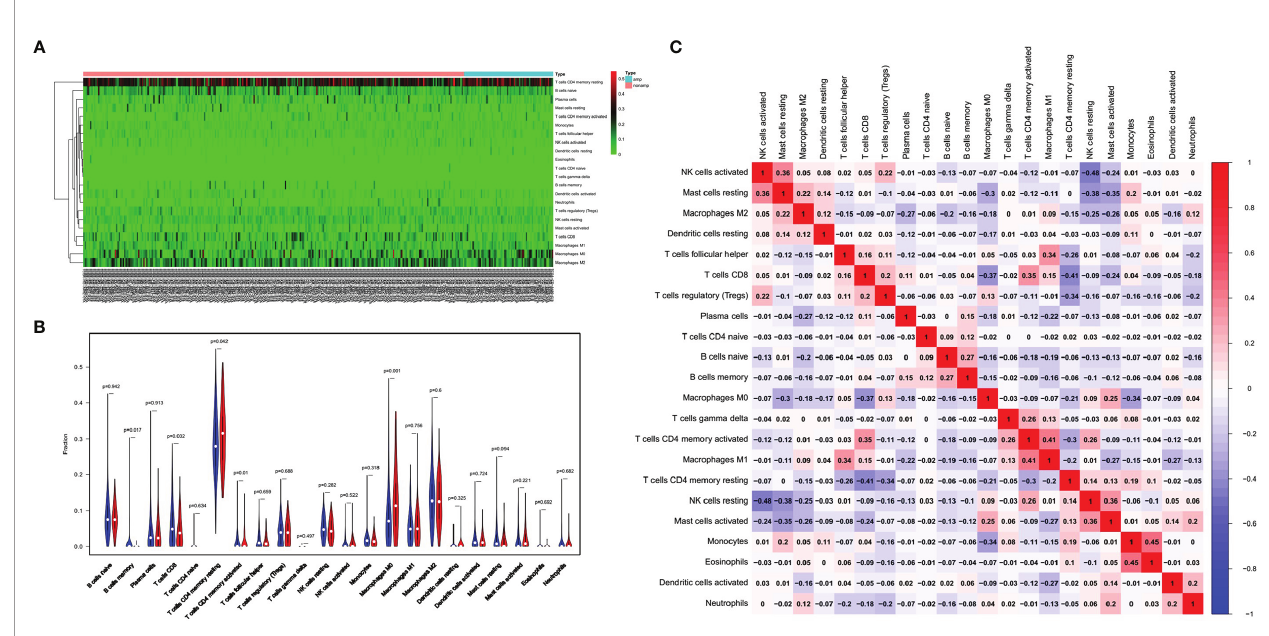
FIGURE 5 | Effects of HER-2 status and immune cell in fi ltration. (A) The heat map of immune cells in GC. (B) The proportion of 22 immune cells in GC. (C) The correlation between the immune cells in fi ltration in GC by Pearson